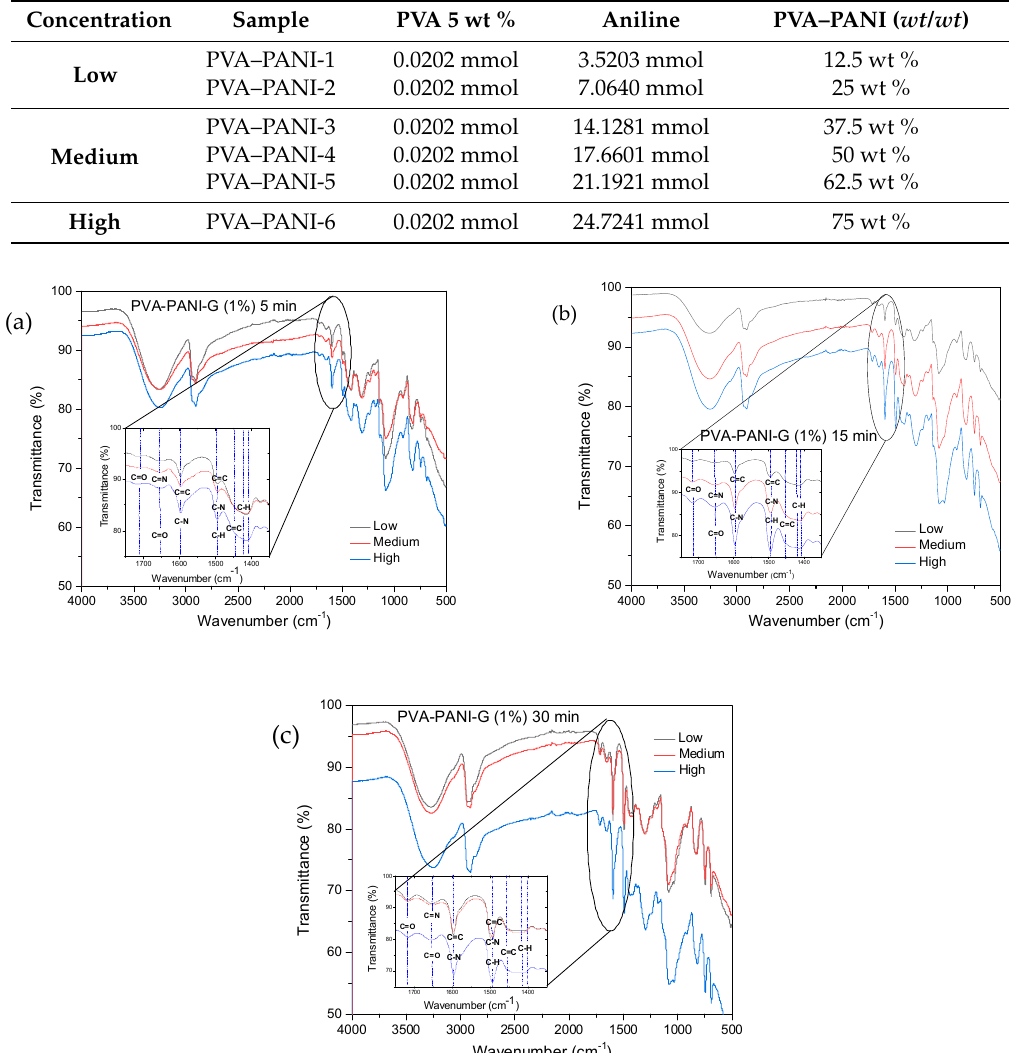
Figure 5. FTIR spectra of PVA–PANI gels at low, medium and high concentration of PANI activated with GA at 1% for: ( a ) 5 min, ( b ) 15 min, and ( c ) 30 min.